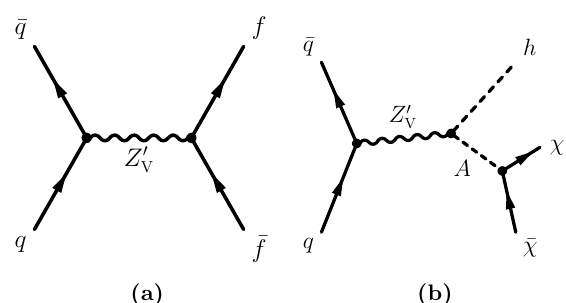
Figure 5. Schematic representation of the dominant production and decay modes for the 2HDM+ Z 0 V